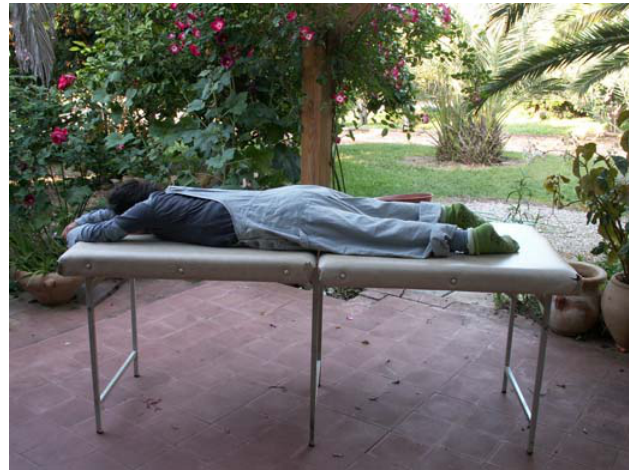
PICTURE 3 . A child on the stomach on a therapy